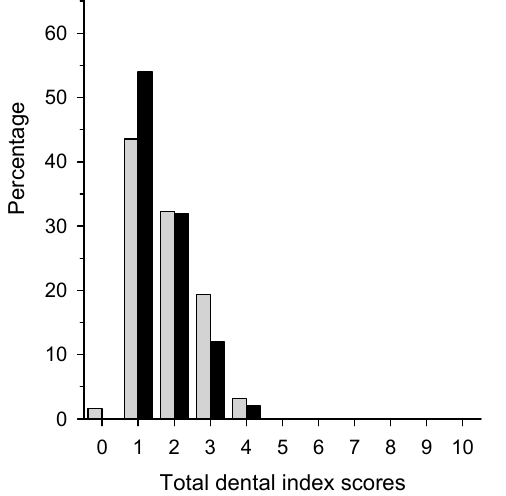
Figure 2. Total dental index scores (TDI) in women without a history of GDM (white bars) and with a history of GDM (dark bars).